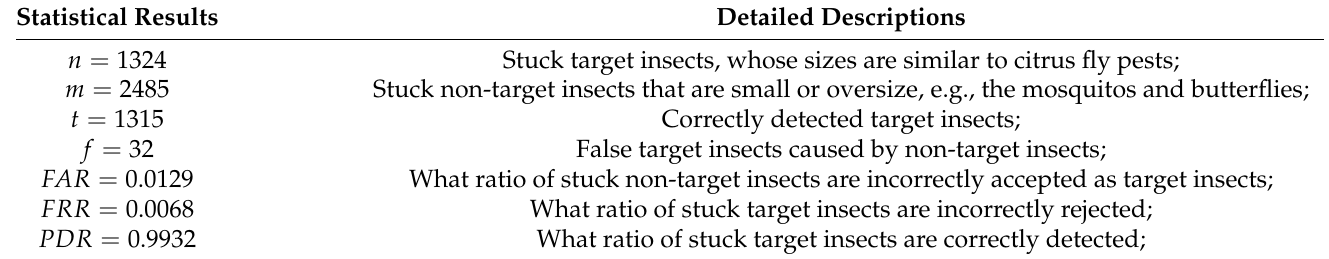
Table 3. Statistical analysis of the detection accuracies on the simulated 1200 samplings. For each sampling, multiple newly stuck insects may be captured or nothing may be stuck on the e-trap. Here, the FAR, FRR, and PDR respectively indicate the False Acceptation Rate, False Reject Rate, and Positive Detection